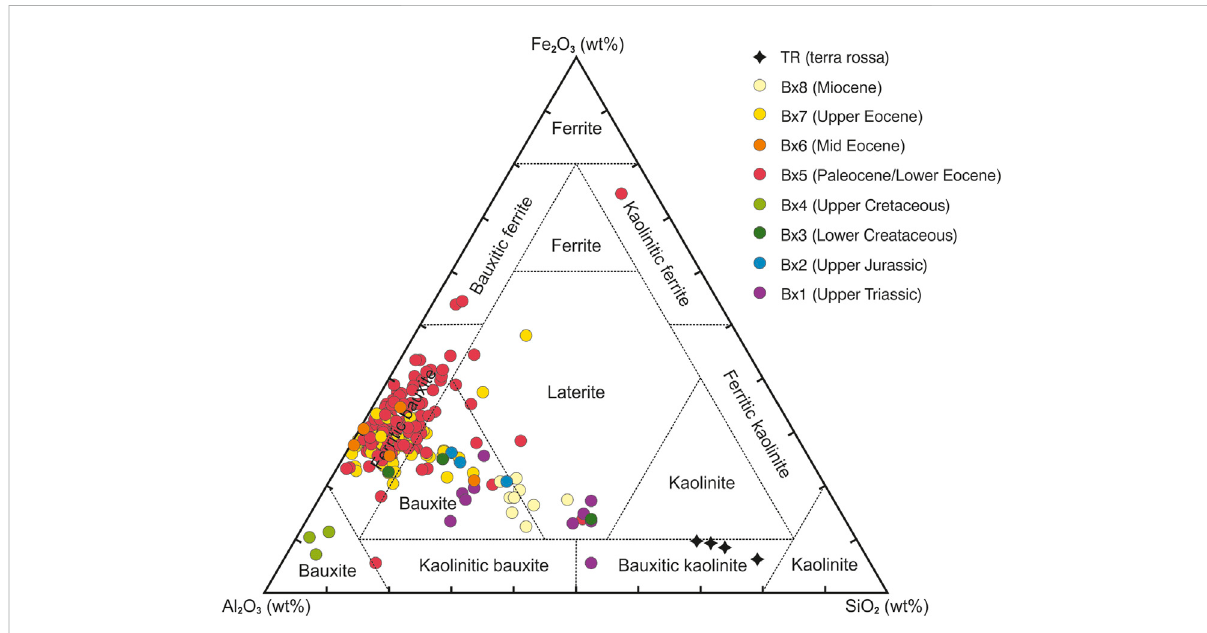
FIGURE 4 TernarydiagramAl 2 O 3 -Fe 2 O 3 -SiO 2 ,showingthemineralogicalclassi fi cationofallanalyzedbauxitesamplesandthesoilgroup(TR)(afterAleva,